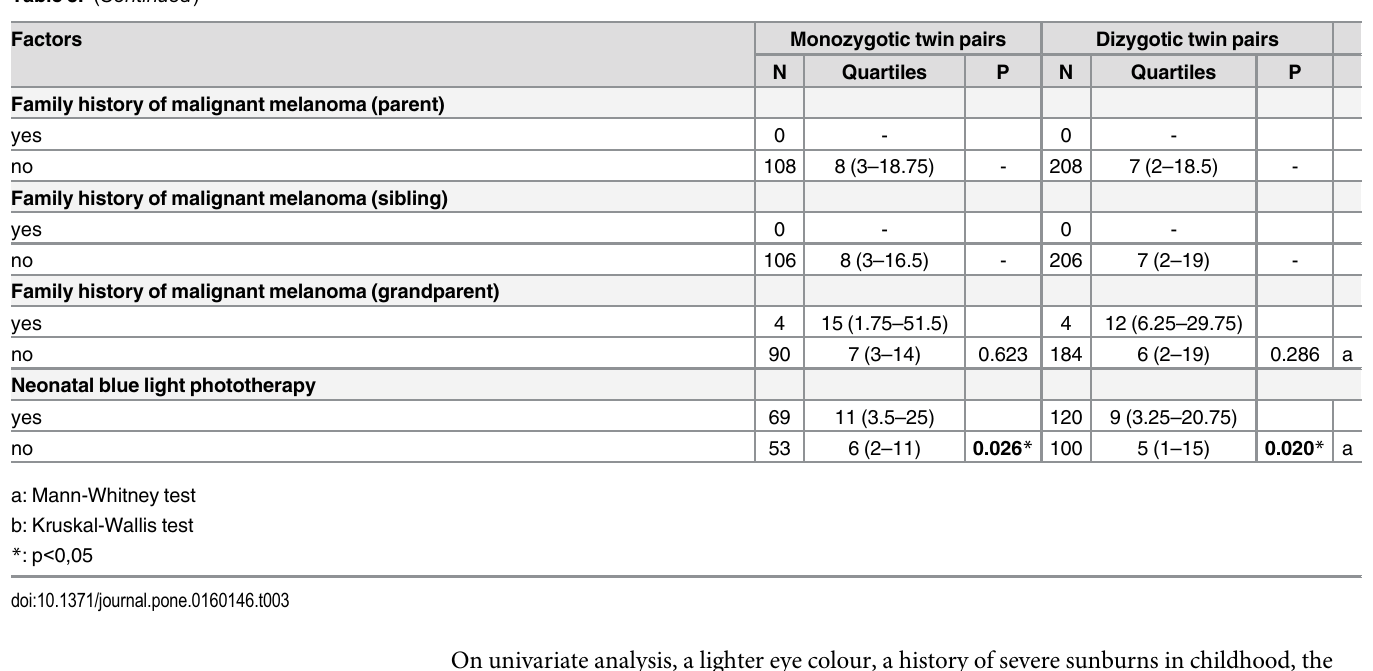
On univariate analysis, a lighter eye colour, a history of severe sunburns in childhood, the frequency of sunbathing, more time spent outdoors during adulthood, the family history of large numbers of cutaneous melanocytic naevi and a history of neonatal blue light photother- apy proved to be associated with a substantially higher prevalence of benign ocular pigmented